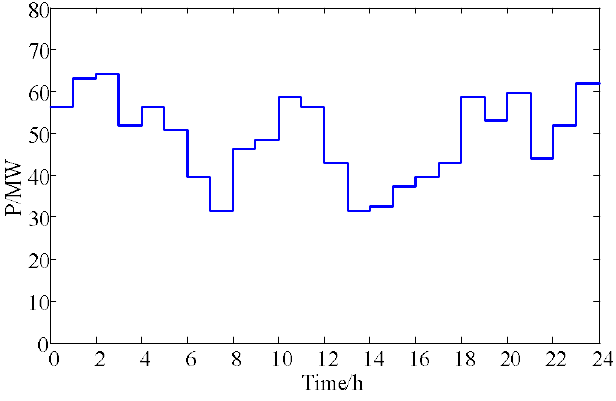
Figure 6. Prediction of wind power in a typical day.